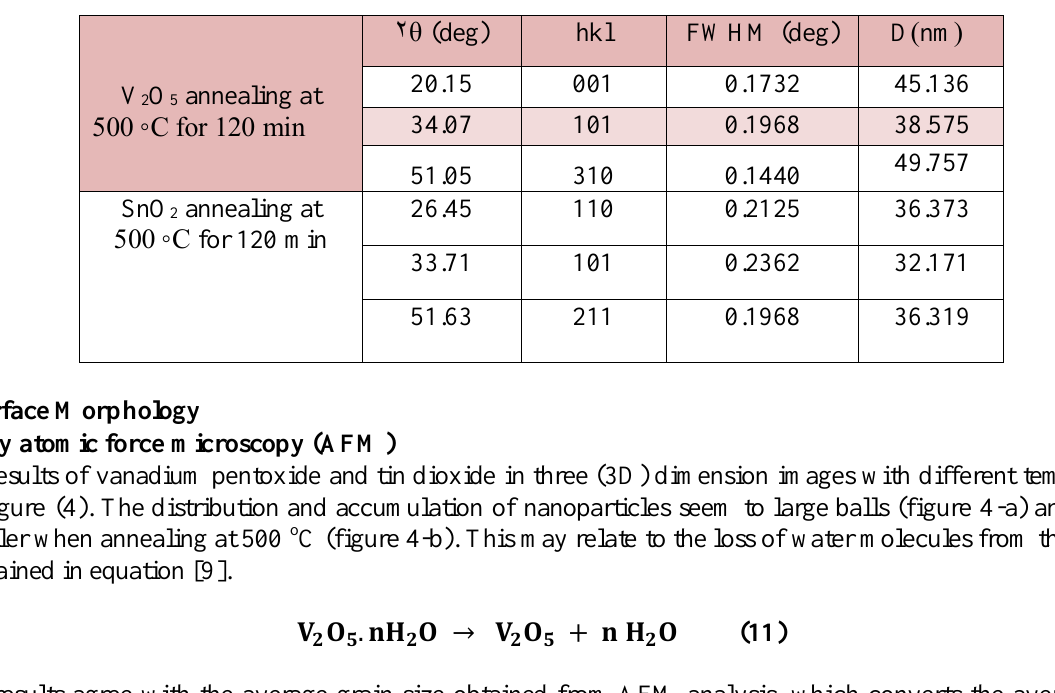
Table (1): The grain size of the V 2 O 5 and SnO 2 nanoparticles calculate by the Scherer